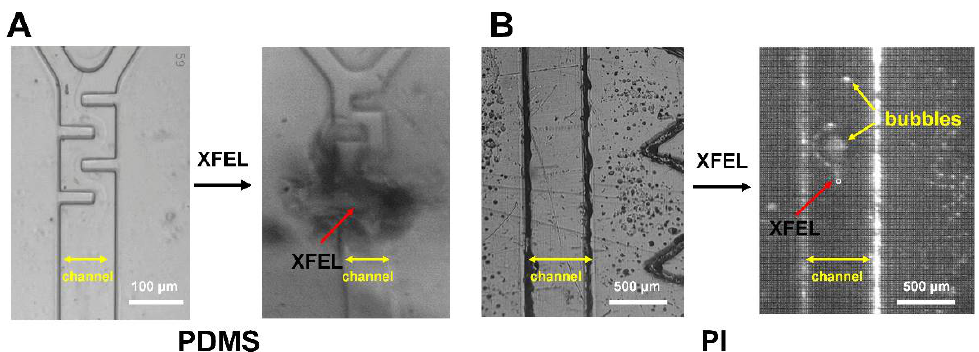
Figure 4. Radiation damage of PDMS- and PI-based microfluidic devices by XFEL. ( A ) The structure of the PDMS-based microfluidics is destroyed by XFEL exposure. ( B ) The structure of the PI-based microfluidic device is not physically destroyed by XFEL; however, the bubbles generated from the solution by XFEL radiation damage are accumulated in the inner channel and interrupt the sample path in the inner channel.